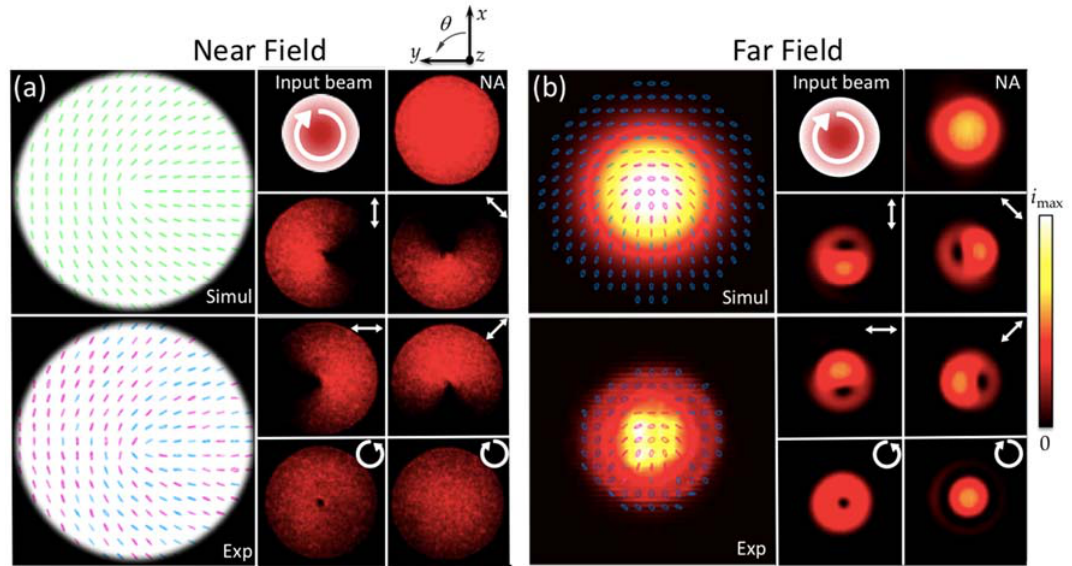
Figure 3. Results for the QW q-plate illuminated with an RCP Gaussian beam ( (cid:96) = 0). ( a ) Results in the near field; ( b ) results in the far field. Simulated and experimental polarization maps, with right and left-handed ellipses depicted in magenta and cyan, and linear polarization in green. Experimental images captured for di ff erent orientations of the analyzer, indicated as white arrows (NA indicates no analyzer).